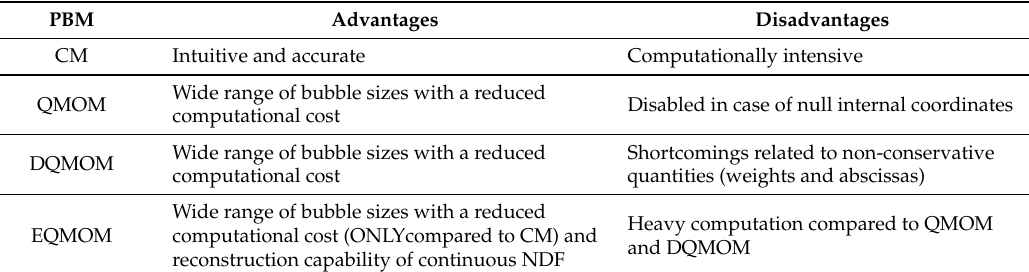
Table 2. An overview of locally polydisperse PBMs. NDF, Number Density